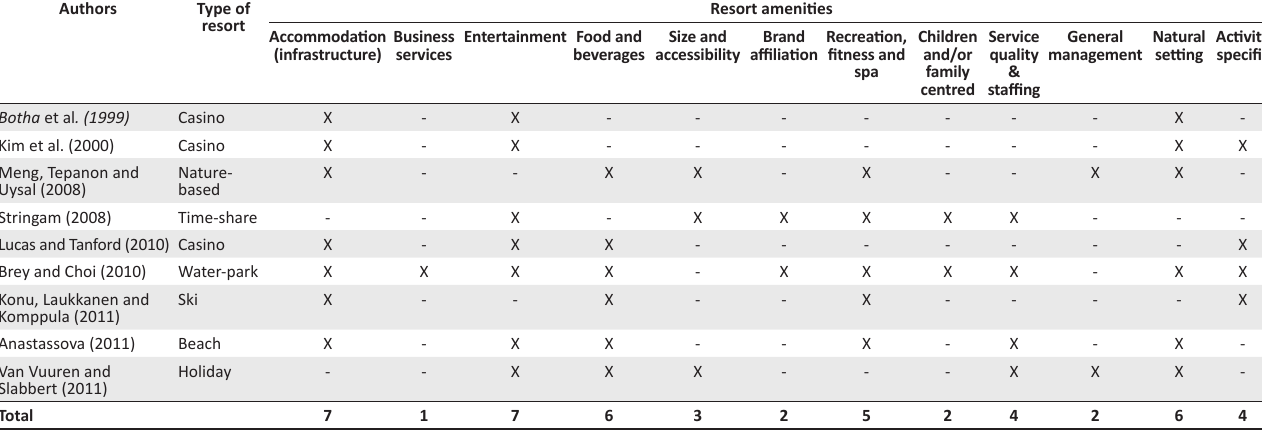
TABLE 3: Previous research findings on resort amenities.